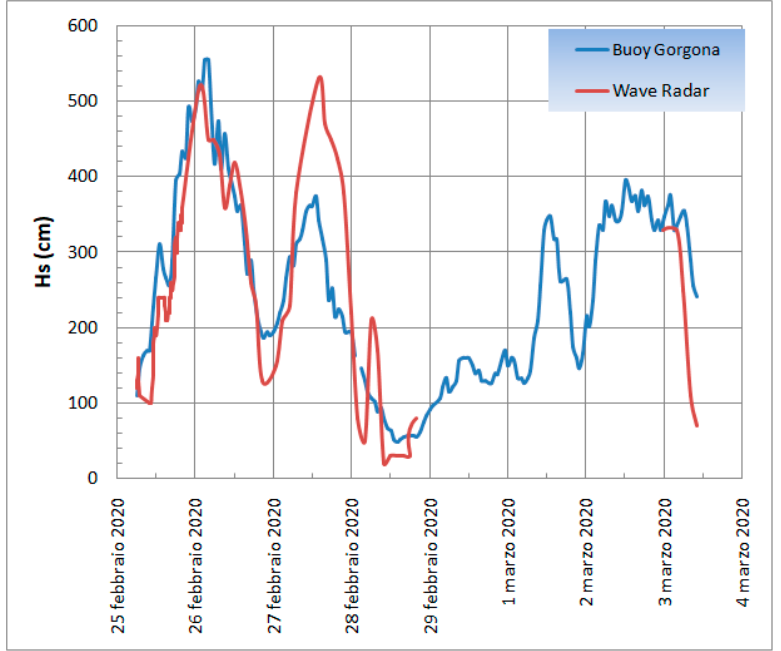
Figure 5. Mean wave height measurements recorded by the Gorgona wave buoy (blue) and Wave Radar (red).